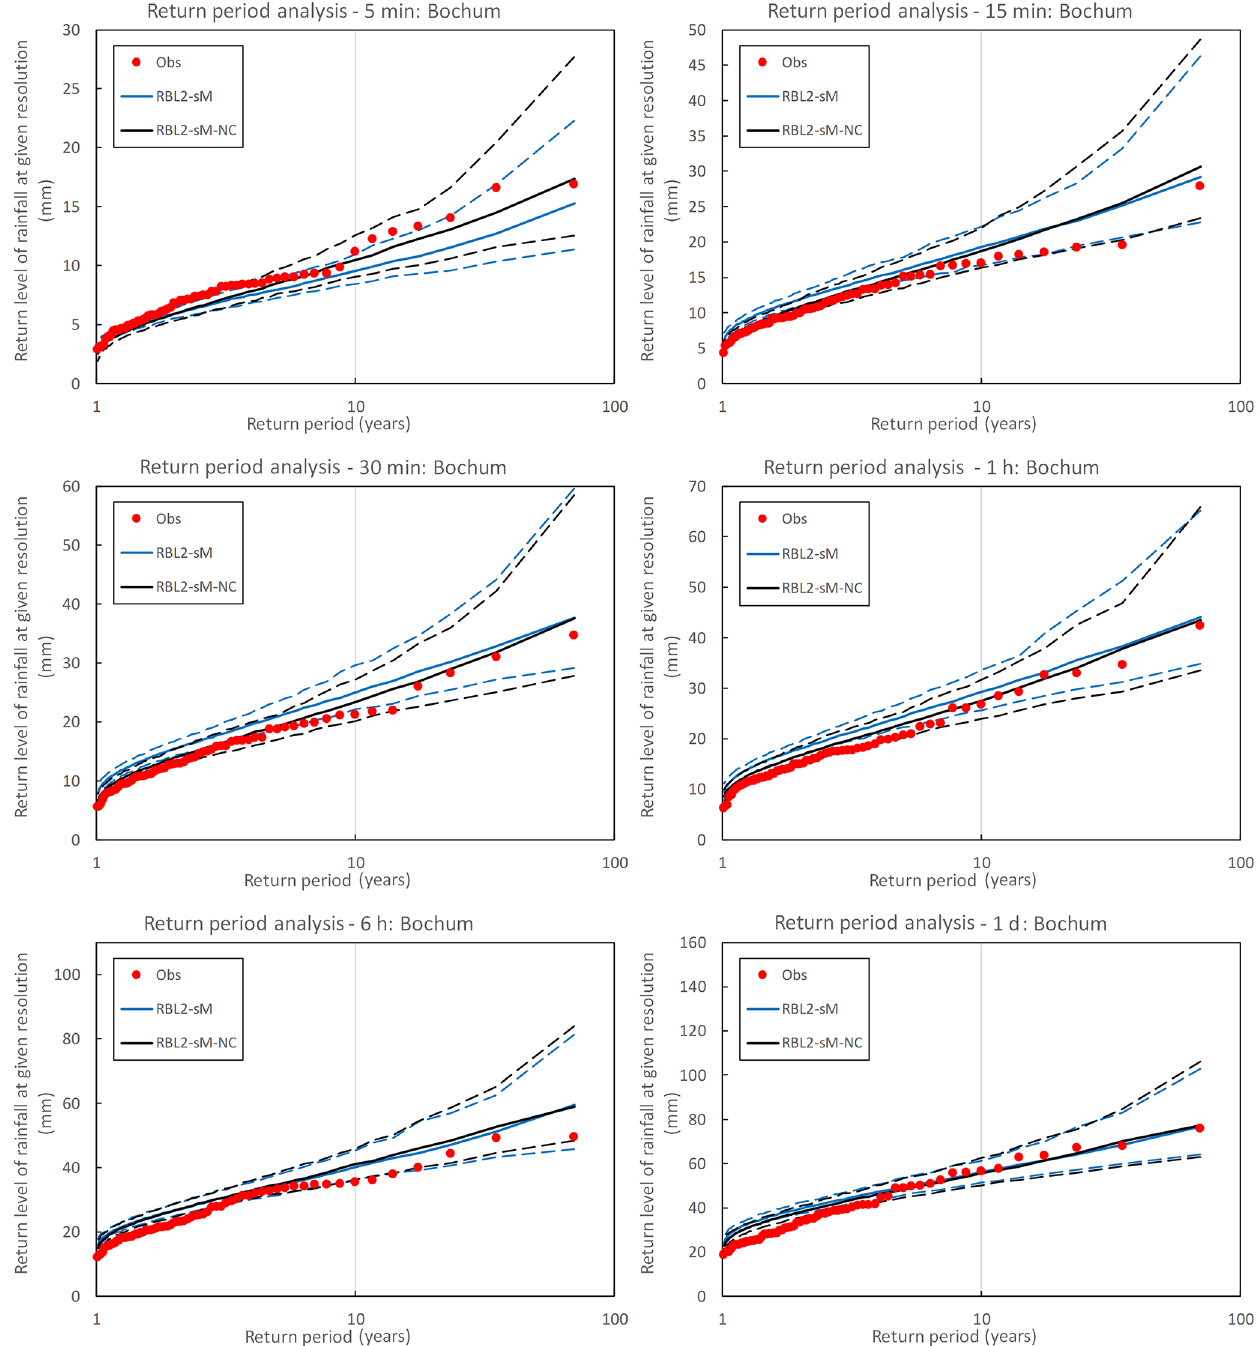
Figure 11. Observed (round markers) and simulated (lines) return levels of rainfall at multiple timescales at Bochum. The simulated return level is sampled from the RBL2 models fitted with the original (blue lines) and the new (black lines) solution spaces of α . The median, 95th and 5th percentile return levels obtained from 250 simulations, each of 69 years, are plotted with solid and dashed lines,